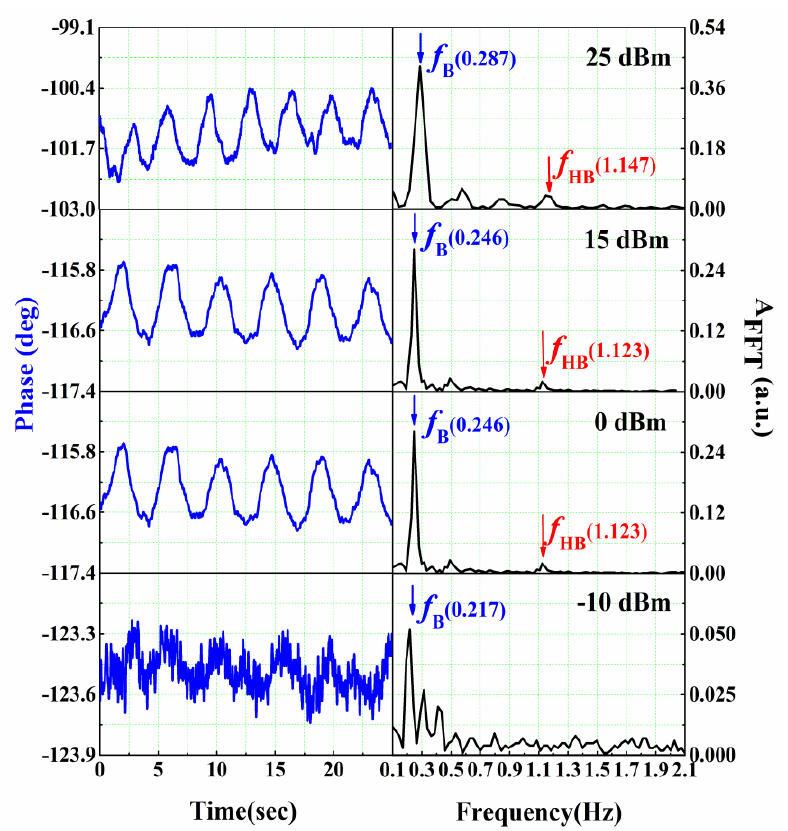
Figure 11. Phase data of the vital sign signals and the corresponding FFT results for different powers.